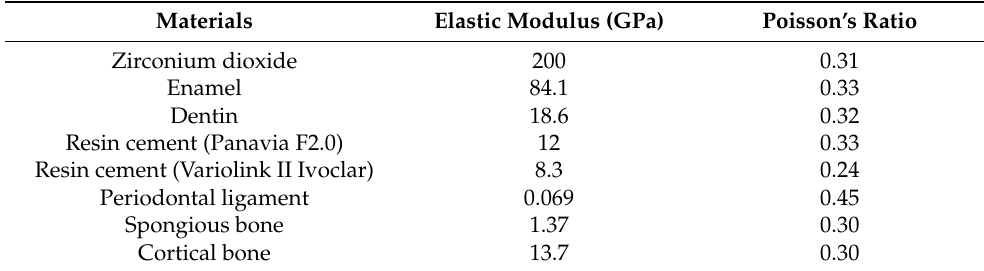
Table 1. Elastic modulus and Poisson’s ratio of the different elements used in numerical simulations [5,12,13].